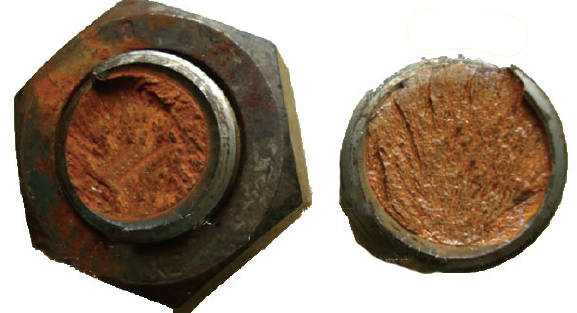
Figure 1. Fracture of two head-cover bolts [3].